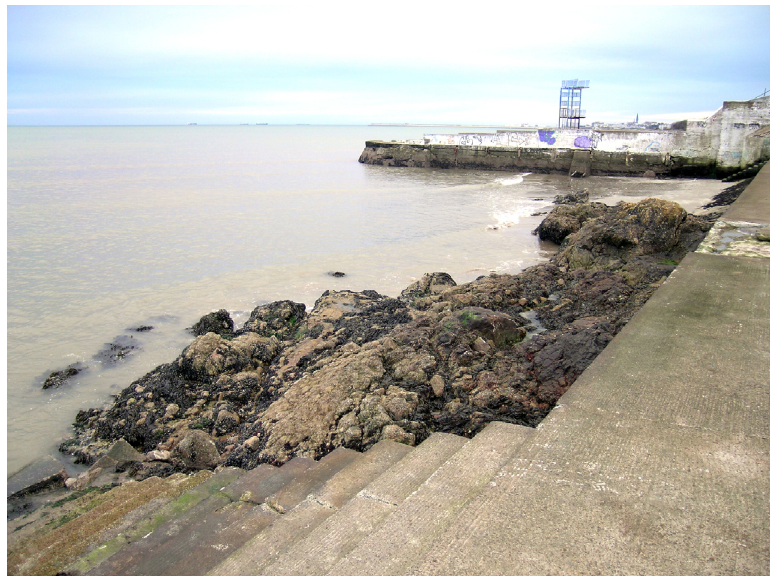
Figure 16. Blackrock Breccia, County Dublin: explosion breccia of granite fragments in granite matrix.